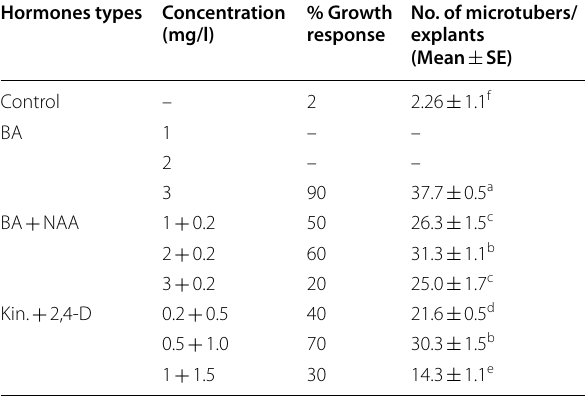
Data represent the mean standard error of 10 replicates for each treatment. ± Means were compared using DMRT (Duncan’s Multiple Range Test) ( P using one-way ANOVA. Mean values within the column with the same letter in superscript are not significantly different [34]